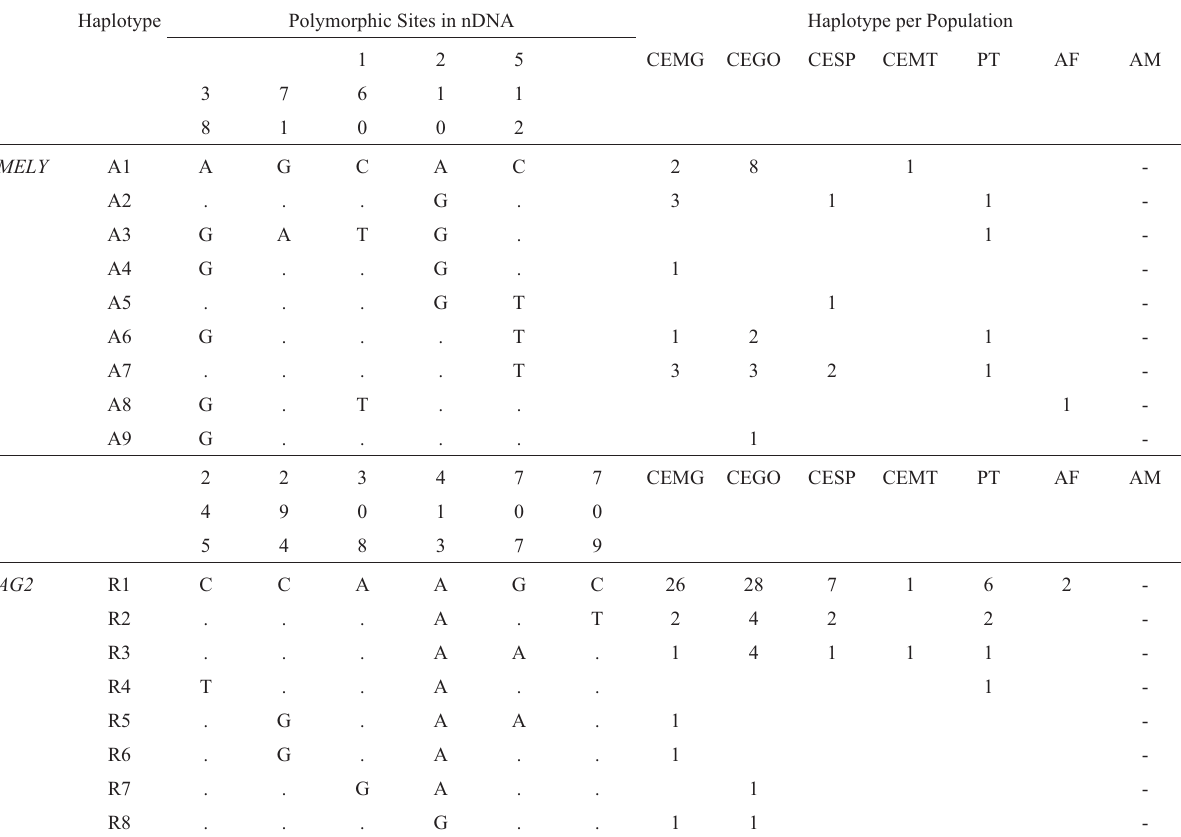
Table2 -HaplotypesfornDNA(AMELYand RAG2 ),polymorphicsitesanddistributionperpopulation. RAG2 isbasedin94sequencesfrom47individ- uals (autosomal data).